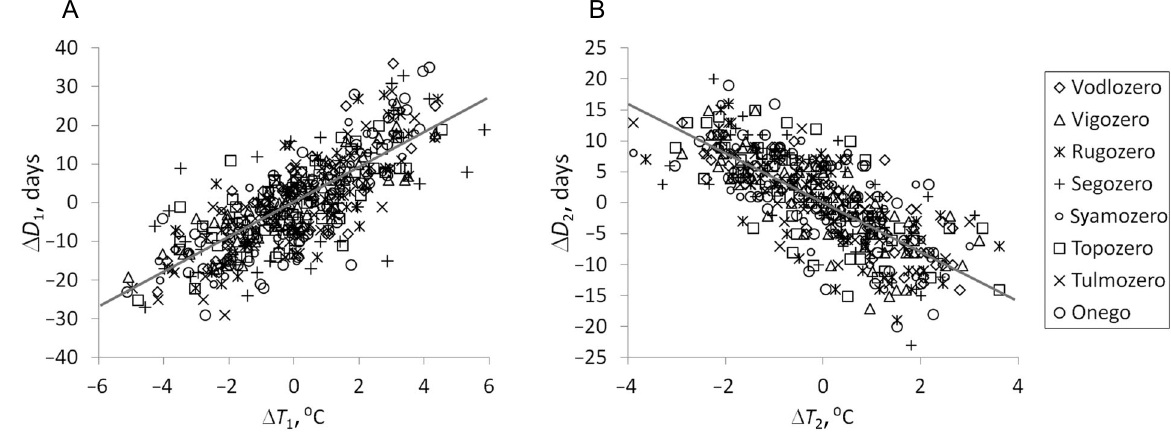
Fig. 5. Scatter diagram of deviations in the freeze ( A ) and break-up ( B ) dates and deviations of mean air temperature in October(cid:150) November and April(cid:150)May from multiyear